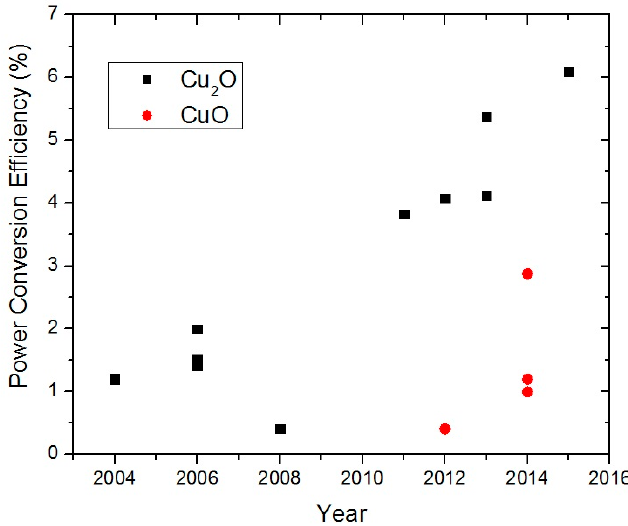
Figure 1. Reported power conversion efficiency of Cu 2 O and CuO heterojunction solar cells vs. publication year. For Cu 2 O, the efficiency for 2008 refers to a device prepared by an electrodeposition method instead of the PLD method [8].